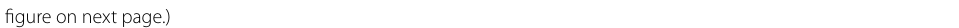
(See figure on next page.) Fig. 4 c-Fos activation map of brain stem structures in the NTG-induced chronic migraine model. A . Representative pictures of c-Fos (red) and NeuN (green) immunofluorescence labeling in the vlPAG. Scale bars and the percentage of c-Fos + cells in NeuN cells ( C ) were found, alleviated by OLC, n (green) immunofluorescence labeling in the Sp5c. Scale bars percentage of c-Fos + cells in NeuN + cells ( F ). alleviated by OLC, n Abbreviations: vlPAG, ventrolateral periaqueductal gray; OLC, olcegepant; Sp5c, caudal part of the spinal trigeminal